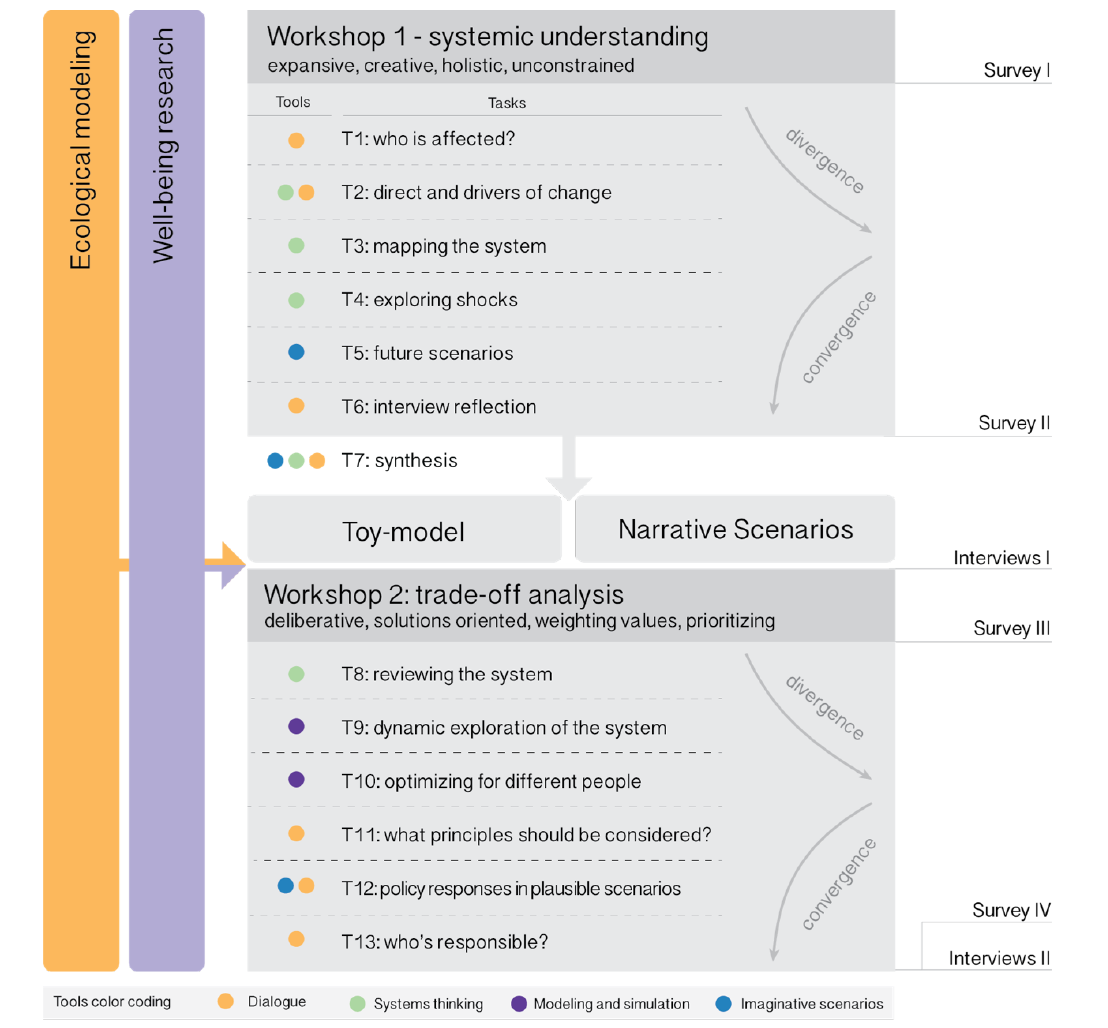
Fig. 1 . Two workshops process design. From top to bottom, the first workshop was about understanding the system, with a focus on imagination, creativity, and exploration. The second workshop was about analysis and how to navigate trade-offs. Each of the 13 tasks (T1-T13) drew from various tools of systems thinking, dialogue, gaming, and scenarios: marked with coloured